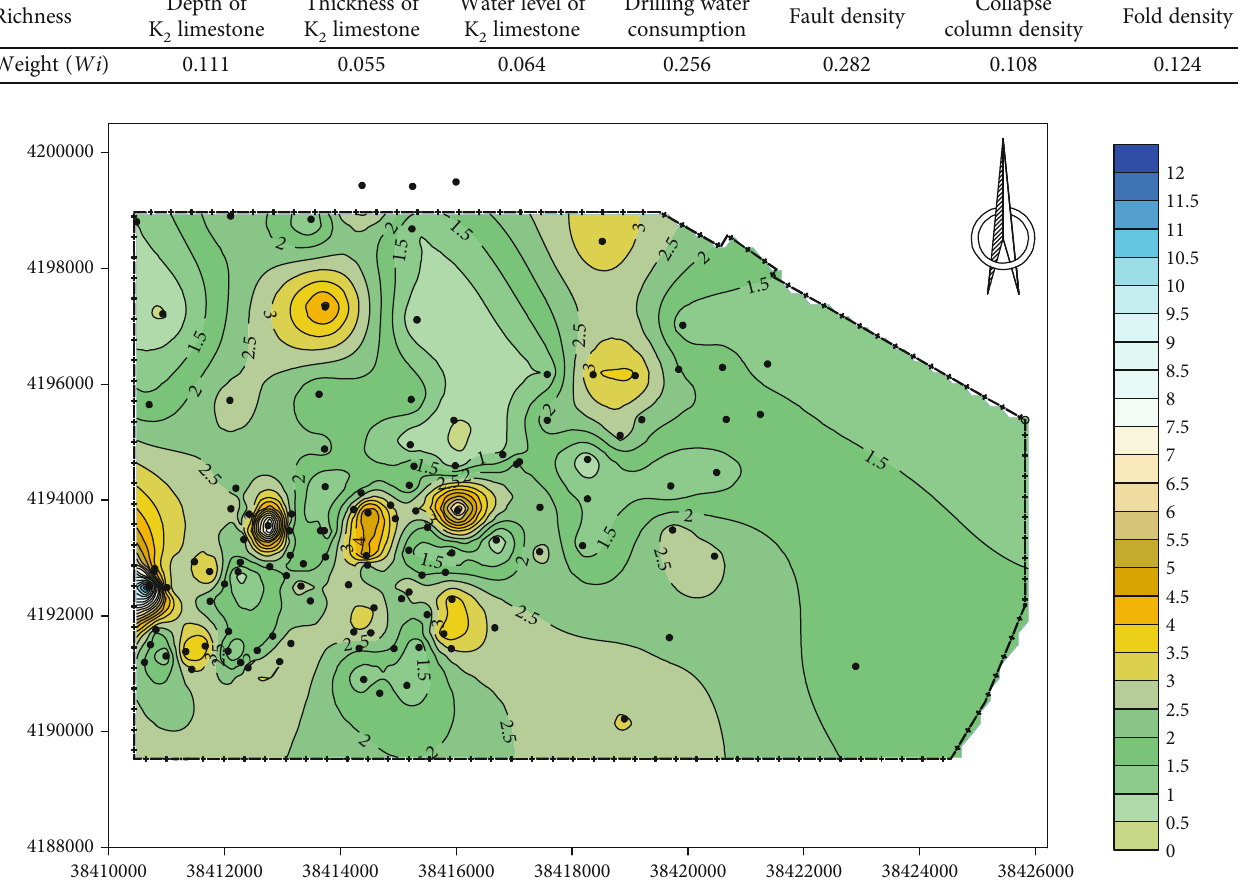
limestone isobaric 2